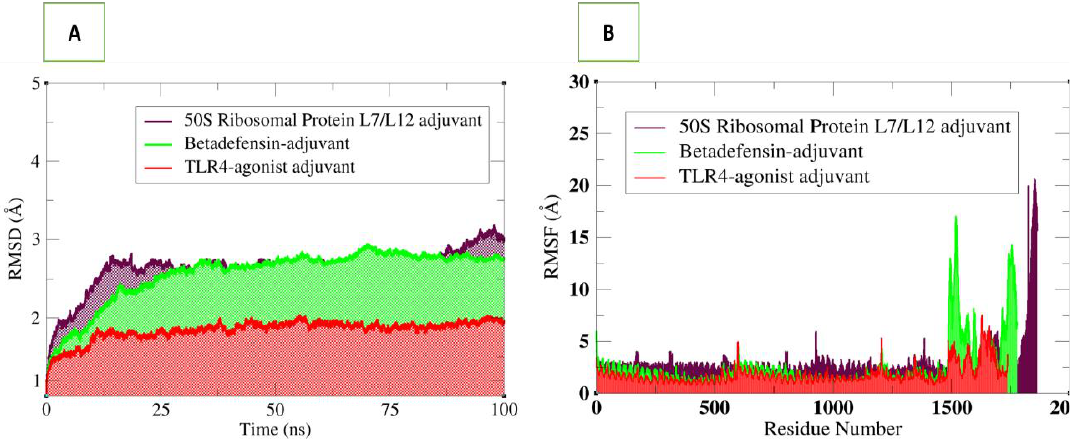
Figure 10. Structural stability analysis of simulated vaccine–receptor complexes: ( A ) RMSD and ( B ) RMSF.